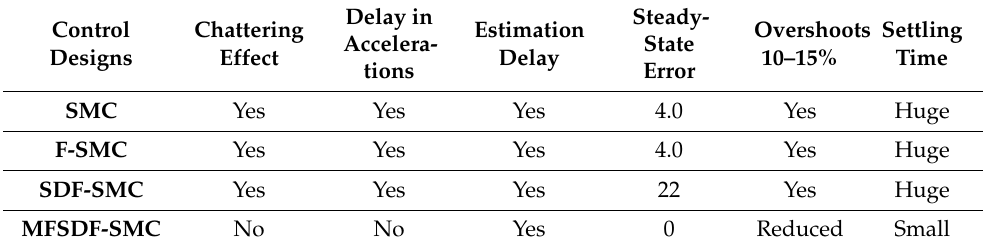
Table 5. Performance summary between SMC, F-SMC, SDF-SMC and